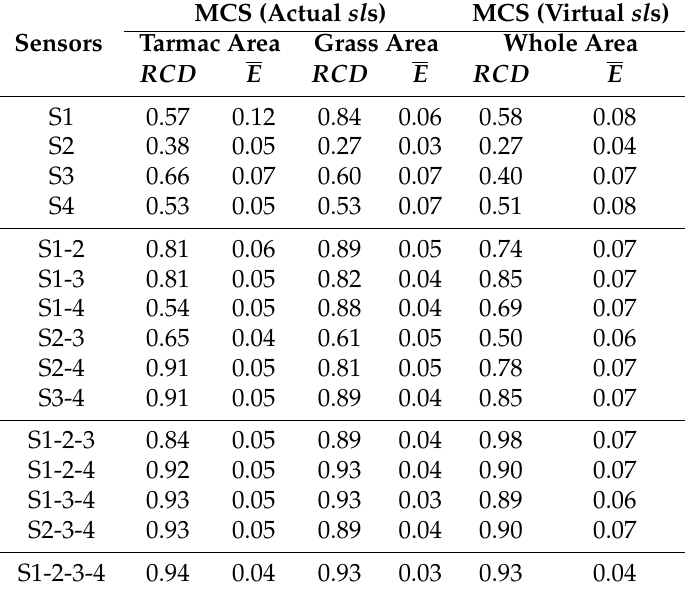
Figure 8. A top view of the straight and curved utilities located based on the simulated hypothesized detections. Located pipes and cables from the synthetic data are shown by blue lines and red lines, respectively. Table 1. Comparison of the utility location results using different sensor combinations. Both the results of MCS with actual survey scan lines ( sl s) and virtual scan lines are presented. RCD is the rate of correctly detected utility length compared with the total utility length in the ground truth, RCD ∈ [ 0,1 ] ; E (m) is the average distance error of the detected utilities. In this table, S1, S2, S3 and S4 represent GPR, PMF, LFEM and VA,